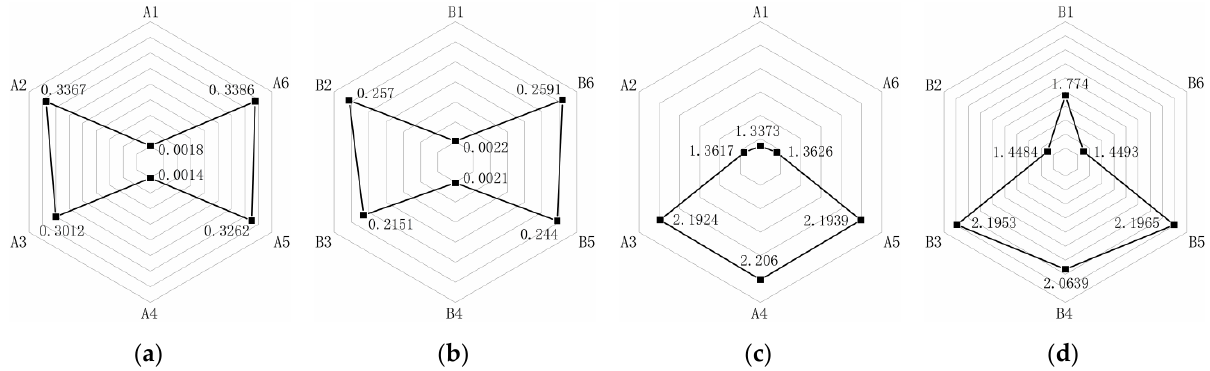
Figure 12. PPD (mm) during double-train traffic: ( a ) PPHD of double-track tunnel; ( b ) PPHD of double-track tunnel with middle partition wall; ( c ) PPVD of double-track tunnel; ( d ) PPVD of double-track tunnel with middle partition wall; A1-A6 and B1-B6 here correspond to that of A1-A6 and B1-B6 in Figure 9.